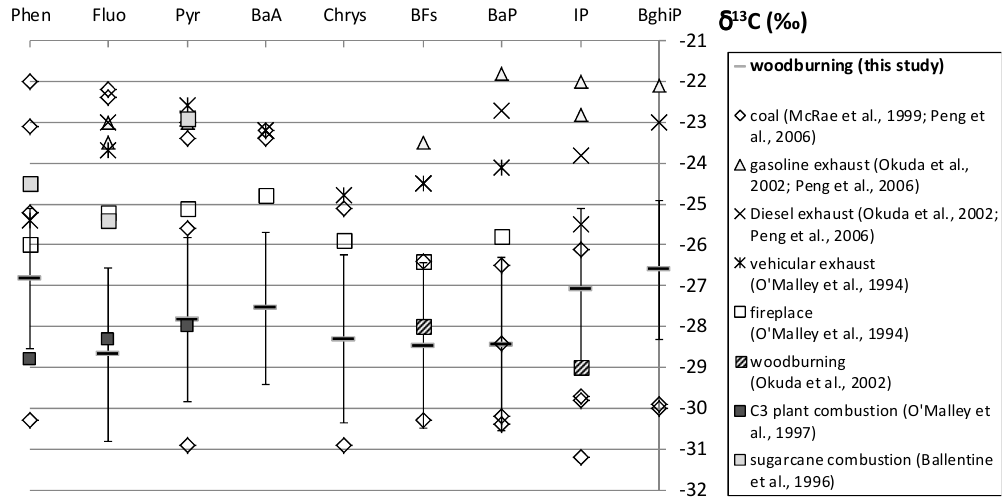
Fig. 4. Comparison of molecular isotopic compositions of particulate-PAHs from wood combustion with results from the literature.